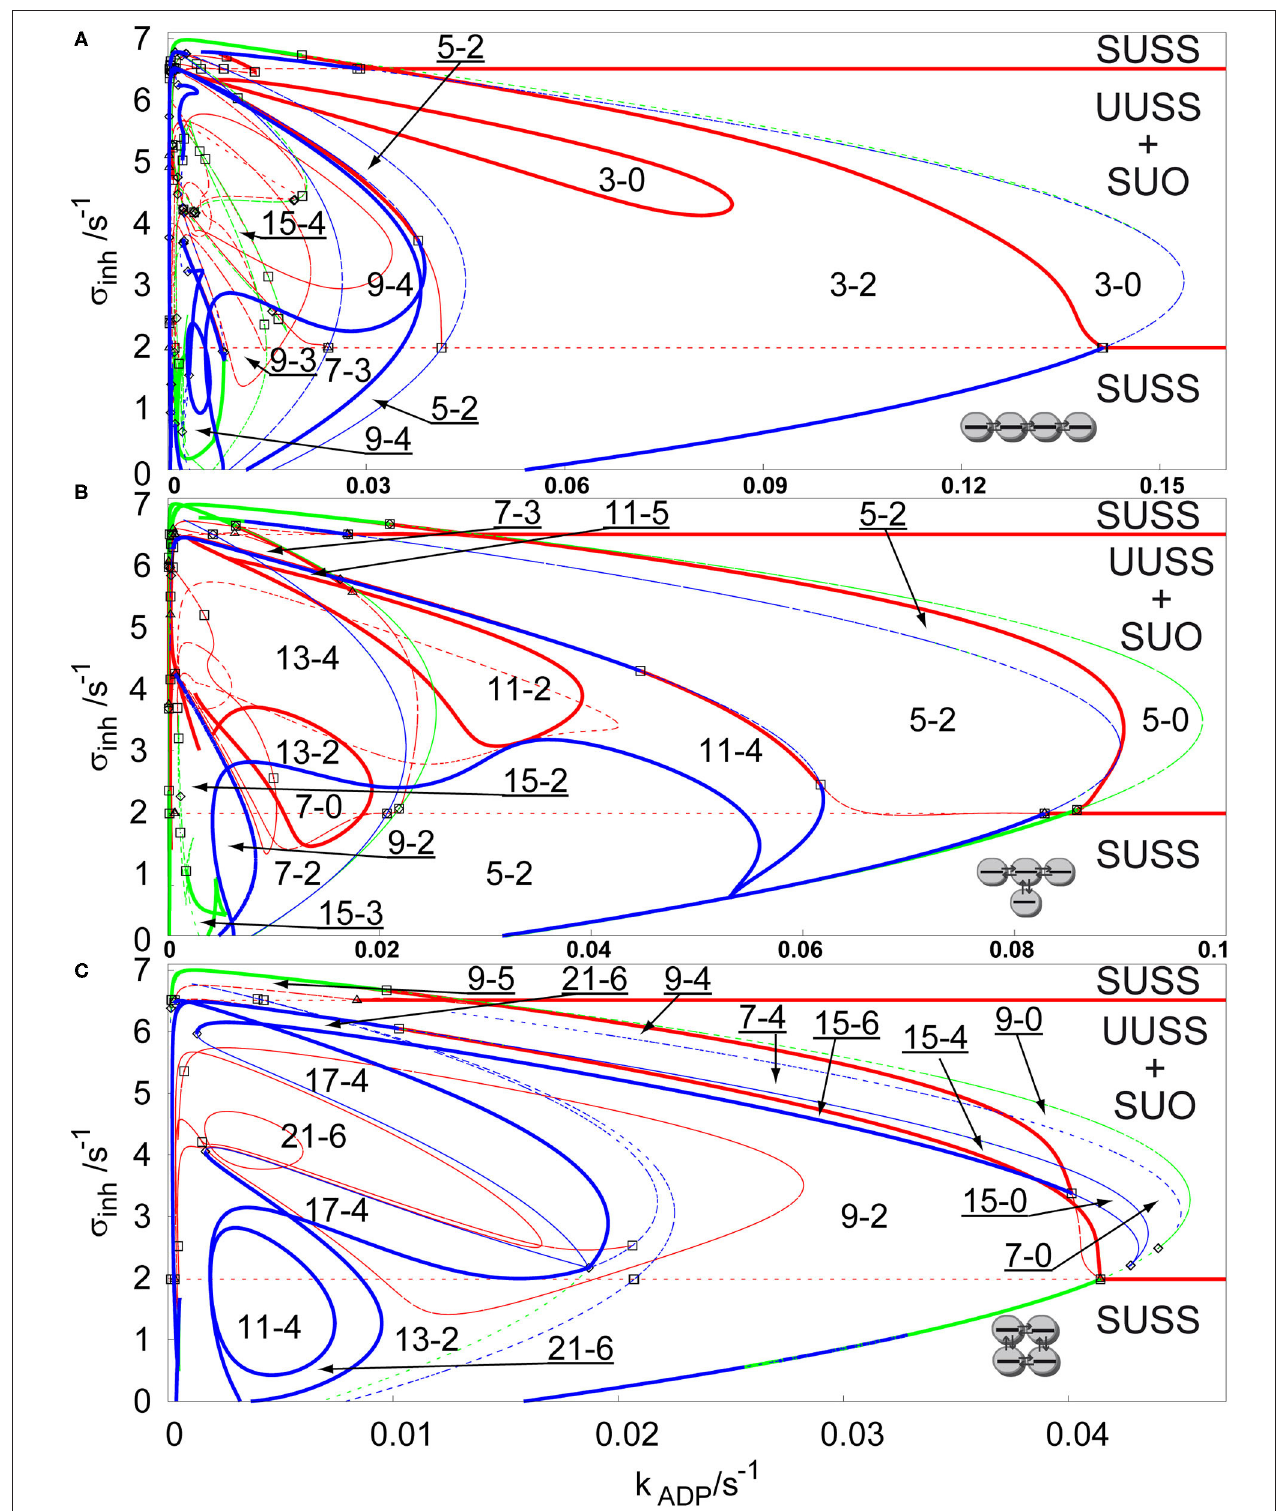
FIGURE 3 | Comparison of bifurcation diagrams of four coupled cells in a parameter plane σ inh and k ADP , q = 100, σ M = 10 s − 1 in: (A) linear array, (B) T-shaped array, (C) cyclic array. Red curve—Hopf bifurcation curve; blue curve—symmetry breaking bifurcation curve; green curve—limit point curve; full line—change of stability across the line, dashed curve—no change of stability across the line; empty square—intersection point of Hopf bifurcation/symmetry breaking bifurcation/limit point curves; empty diamond—Bogdanov-Takens bifurcation point; empty triangle—double Hopf bifurcation point. Each parameter region is marked by a pair of numbers m,n, where m is total number of stationary states and n is the number of stable stationary states.